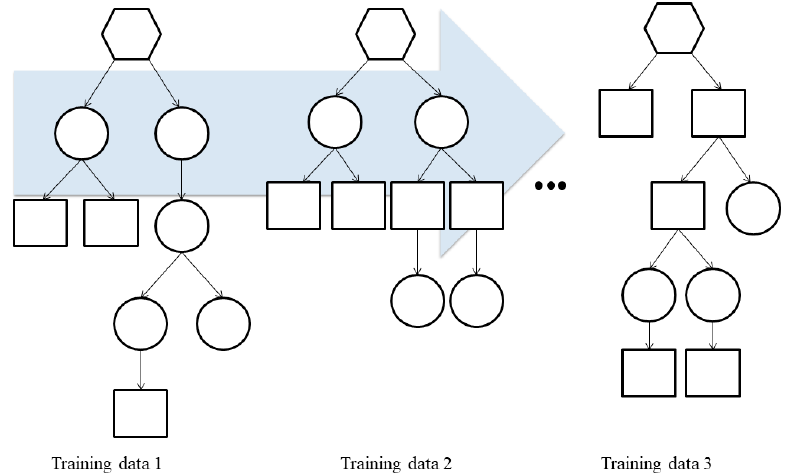
Figure 2. Ensemble classifiers that combines many single decision trees .